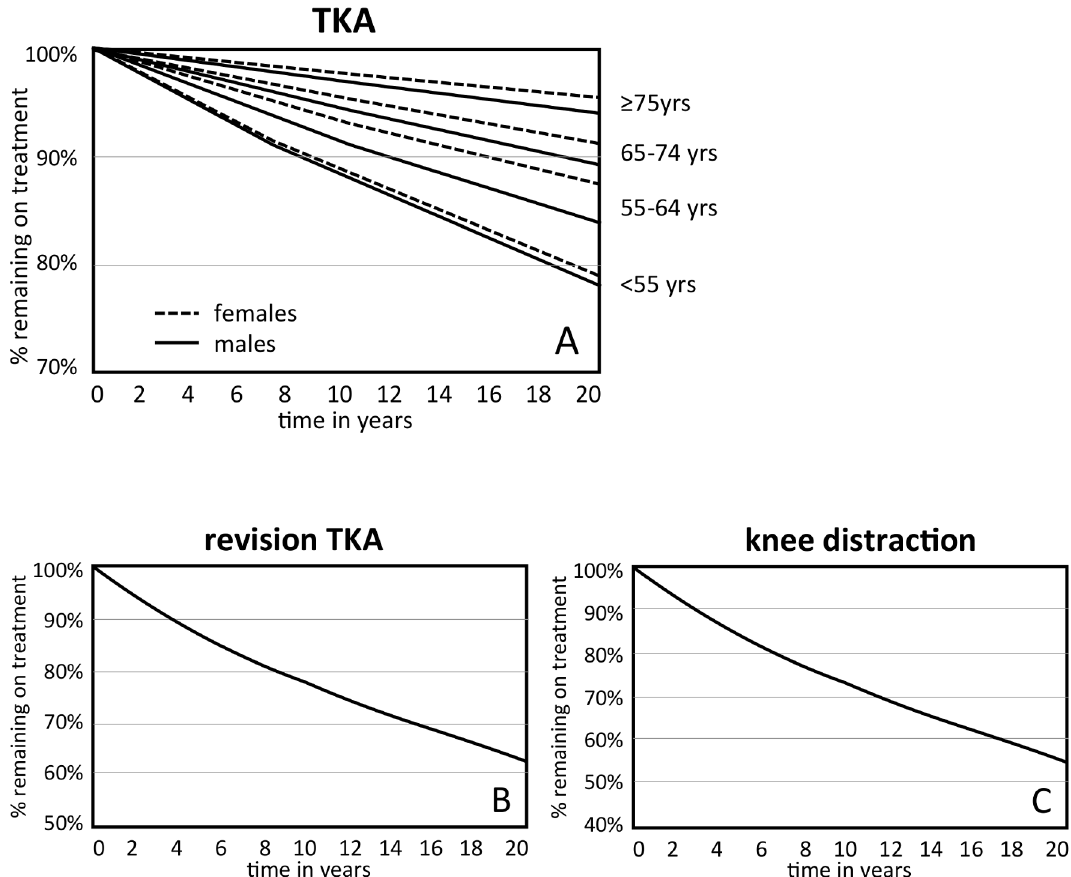
Fig 1. Survival curves. A Parametric Weibull distribution was fitted to extrapolate the time to failure for the different procedures (per age- gender category): for TKA (A) , revision TKA (B) , and knee distraction (C) .